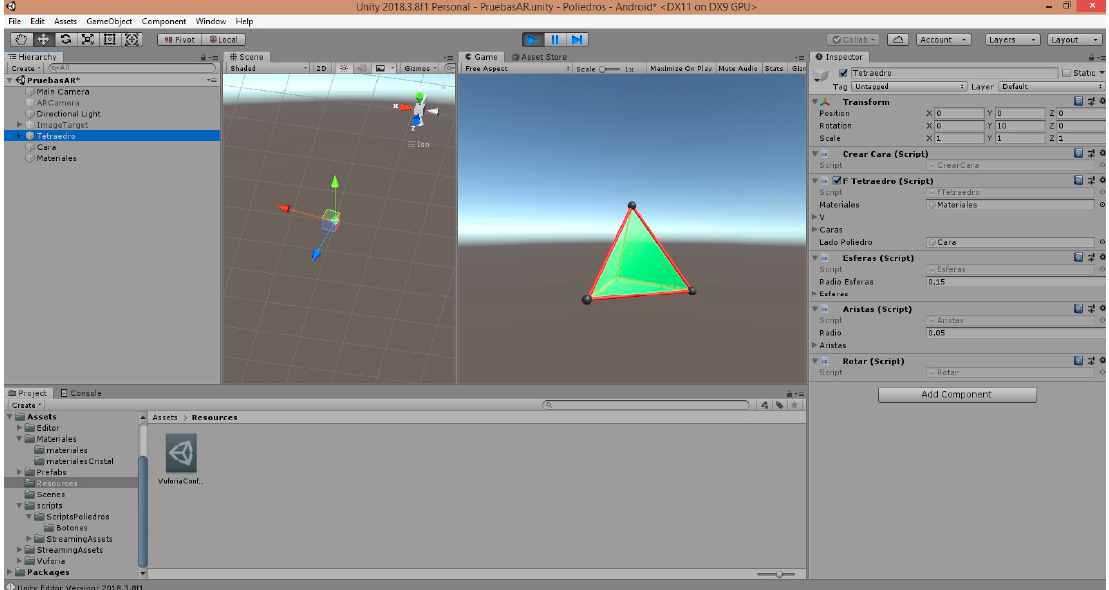
Figure 2. Tetrahedron created in Unity.